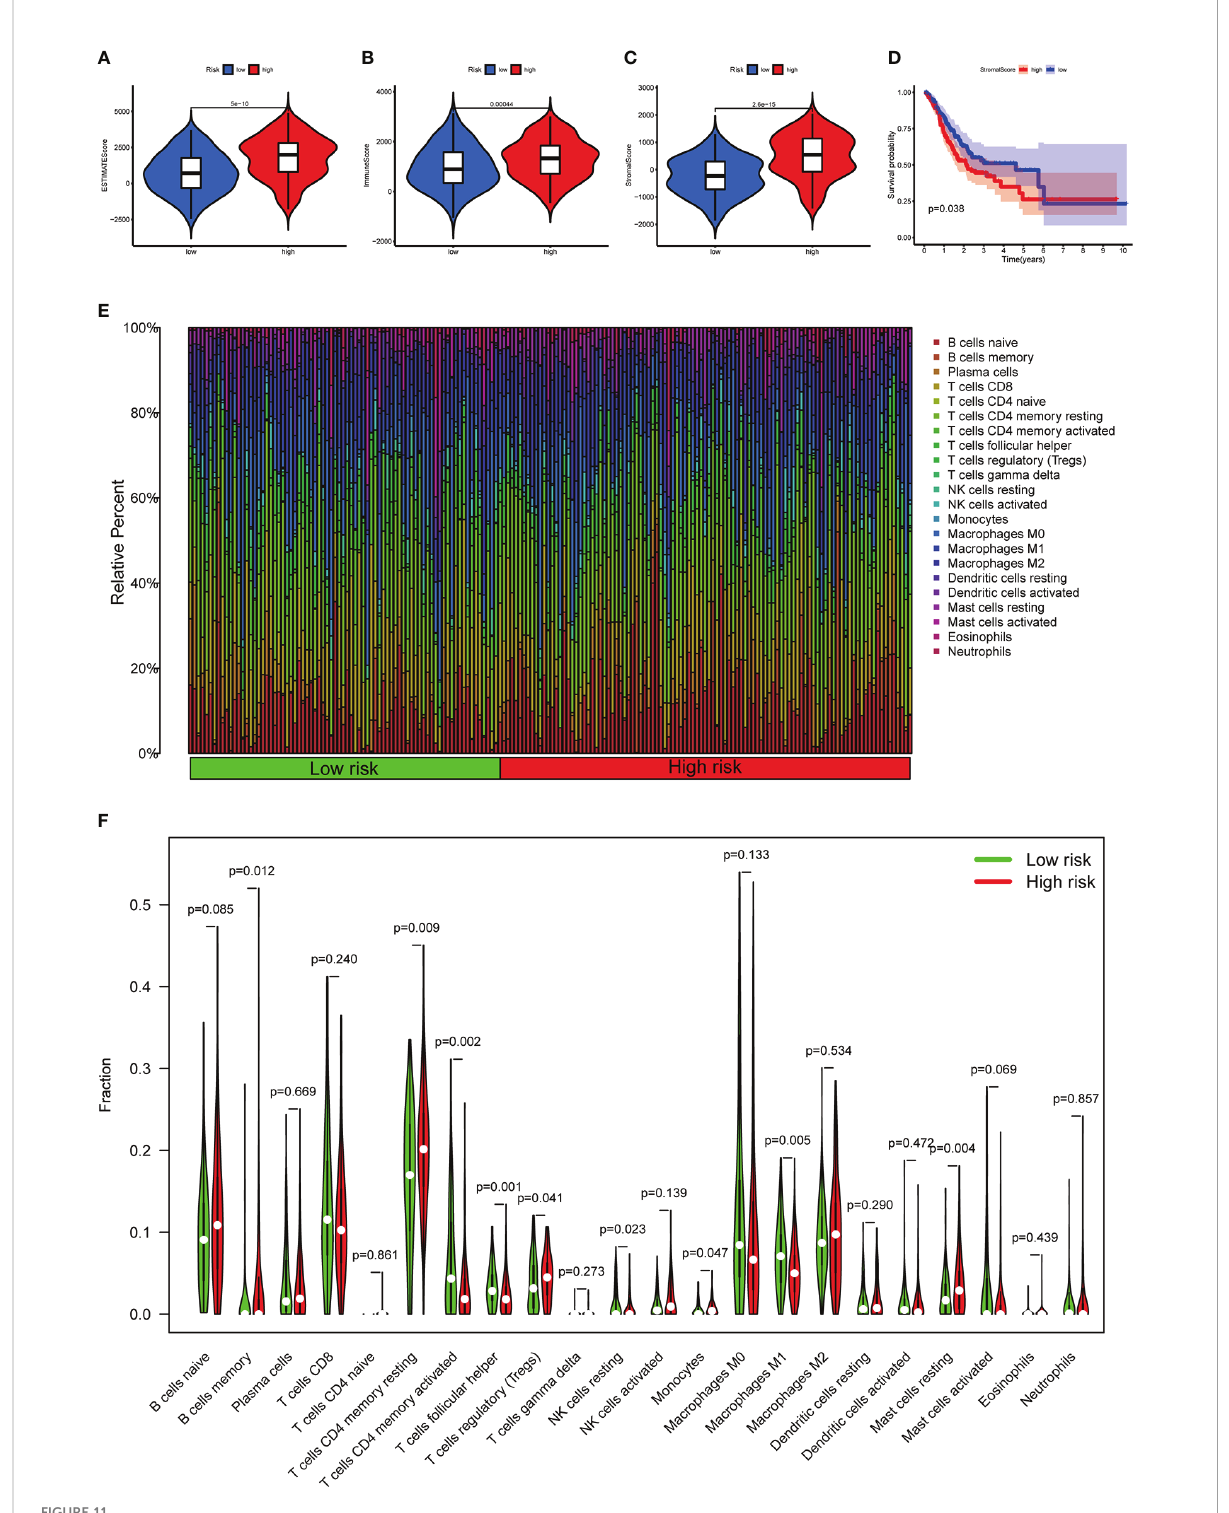
FIGURE 11 The relationship between different risk subgroups and TME. (A – C) Comparison of ESTIMATE scores, Immune scores, and Stromal scores in the high-risk group and low-risk group. (D) The OS of patients with high stromal scores was signi fi cantly lower than those with low stromal scores. (E) The distribution of TIICs in the high-risk group and low-risk group. (F) Violin plot showing differences in TIICs between the high-risk group and low-risk